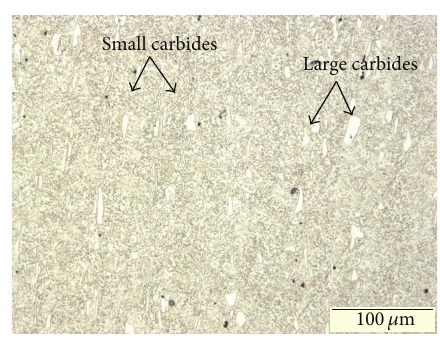
Figure 4: SEM micrograph of as-received AISI D2.